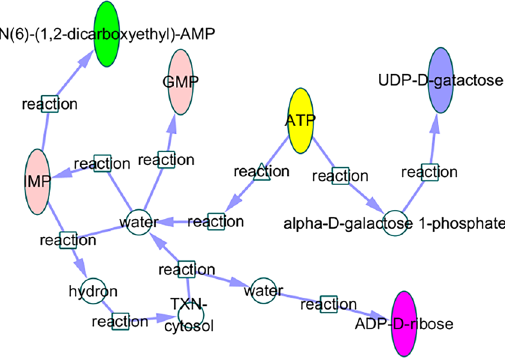
Figure 8. Metabolic pathways of ATP and the verified biomarkers (Yellow indicates ATP, blue indicates UDP- D-galactose, rose red indicates ADP–D-ribose, pink indicates IMP and GMP and green indicates N6-(1,2-